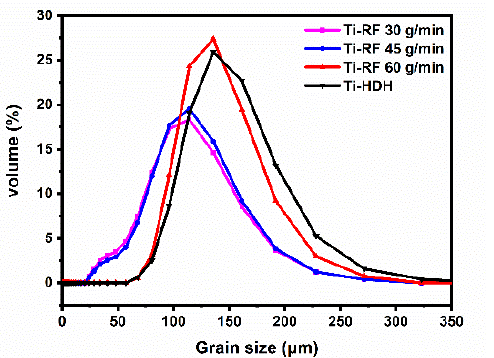
Figure 3. The particle size distributions of HDH titanium powders, before and after radio-frequency plasma treatment.